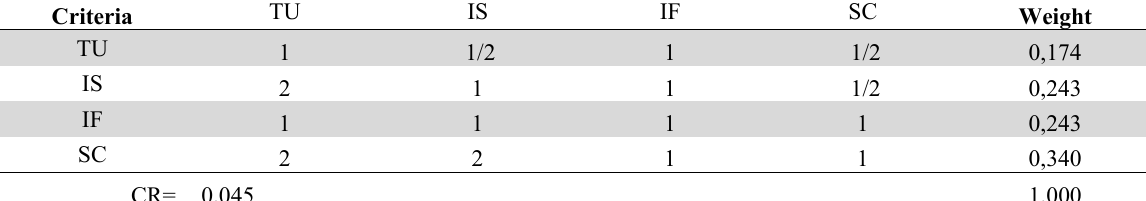
Pairwise comparison matrix aggregation for Adaptive Capacity Vulnerability.